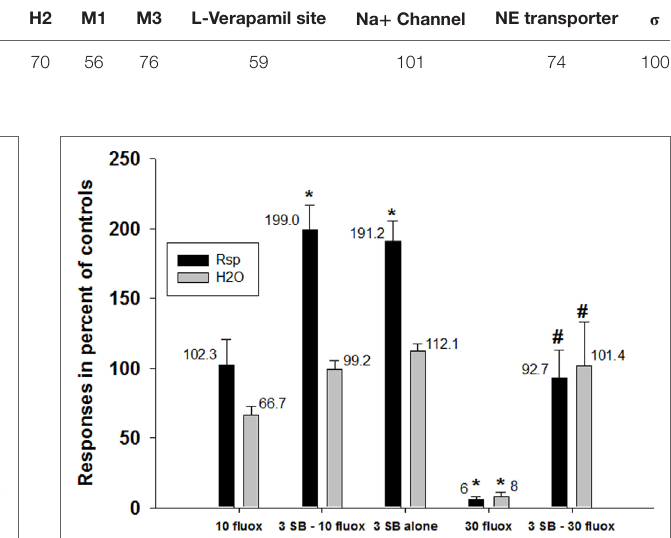
FigUre 3 | Prevention of effects of fluoxetine by a 5hT 2c receptor antagonist . Fluoxetine (30 mg/kg, i.p.) significantly suppressed both the number of responses emitted and the amount of water consumed in rats under a schedule of food delivery engendering excessive drinking. Co-dosing with SB-242084 (3 mg/kg) significantly attenuated these decreases. Each bar represents the mean ± SEM of five to eight rats. * p < 0.05 compared to vehicle (Dunnett’s test). # p < 0.05 compared to fluoxetine alone (30 mg/kg) (Dunnett’s test).